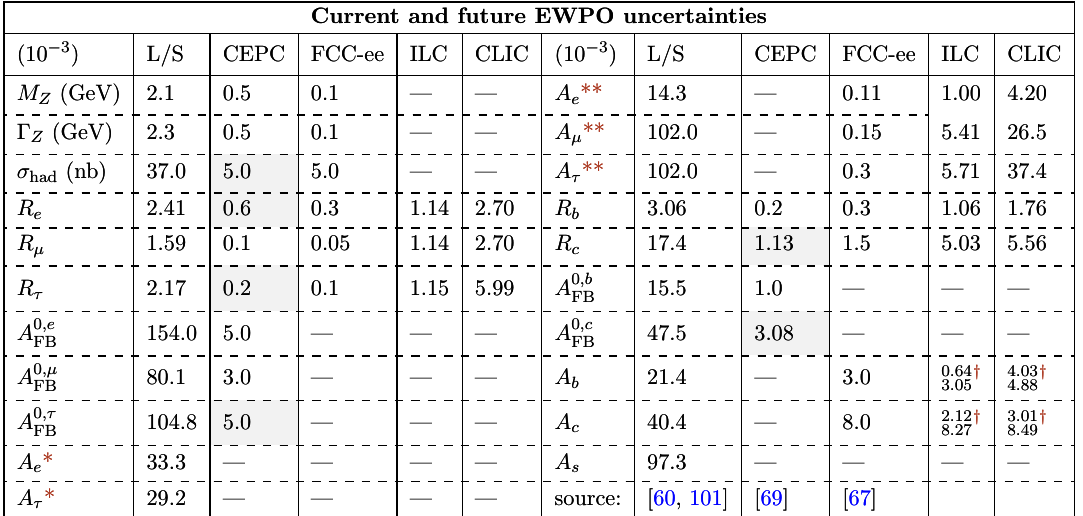
Table 5 . Comparison of current precision of EW observables (L/S) vs. the projections for CEPC, FCC-ee, ILC and CLIC. Projections correspond to 8 ab (cid:0) 1 of integrated luminosity at CEPC [67] and 150 ab (cid:0) 1 at FCC-ee [69]. For ILC and CLIC the numbers correspond to the projections